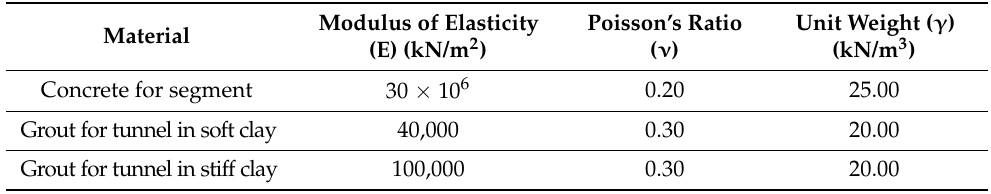
Table 4. Properties of concrete lining and grout materials.